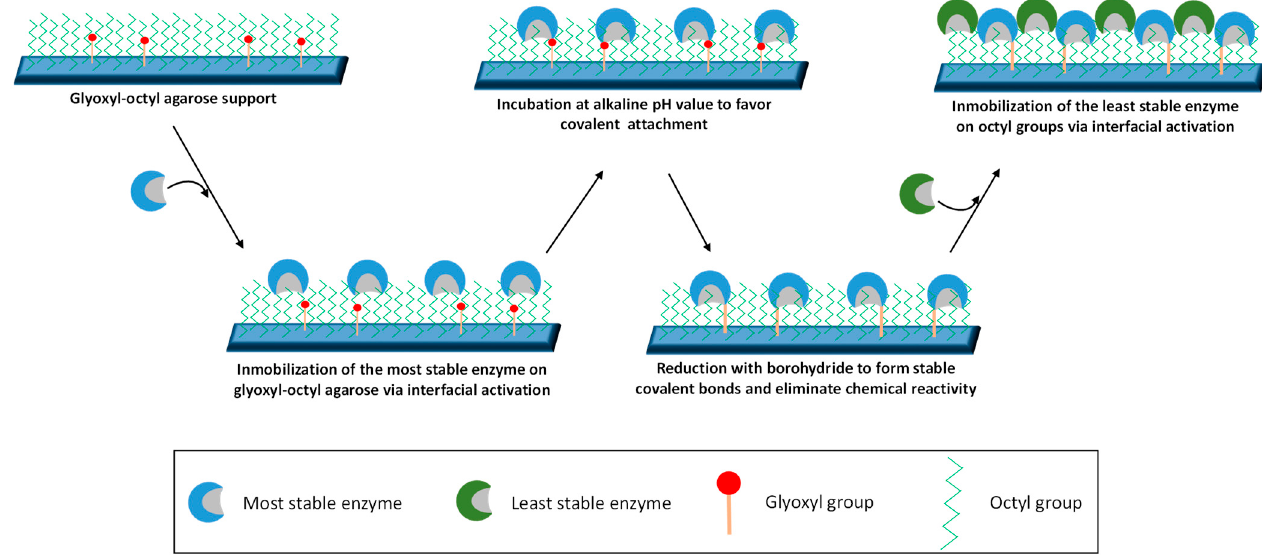
Figure 10. Using octyl-glyoxyl supports to prepare a combi-biocatalyst by lipase immobilization enables the reuse of the most stable enzyme to prepare a new combi-biocatalyst after the least stable enzyme inactivation. The most stable enzyme is covalently immobilized, the support is reduced to eliminate the chemical reactivity, and then the least stable enzyme is just physically immobilized via interfacial activation. The least stable enzyme may be selectively released by using detergents.